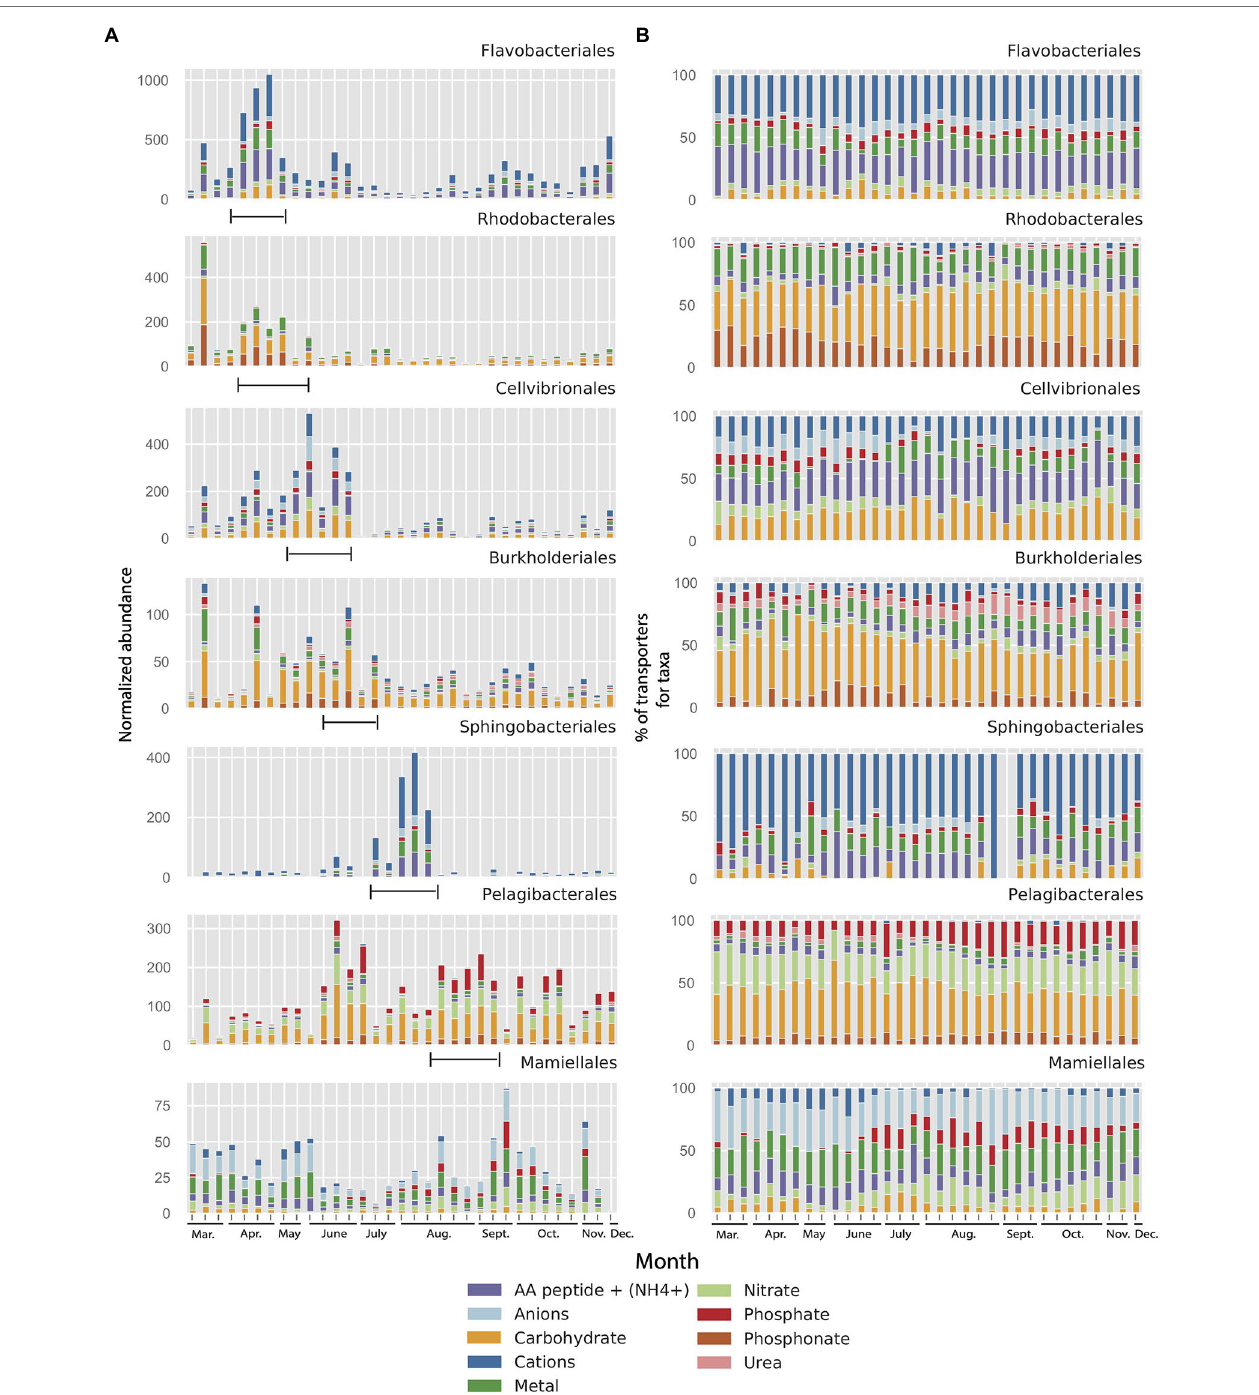
FIGURE 6 | (A) Normalized abundance of transporter clusters related to different substrate categories and their affiliation to seven microbial taxon (order) in the LMO 2012 metagenome dataset (10 months). Range mark in figure added manually to indicate the succession of transporter peaks. (B) Same data as in panel A but as percentages for each of the seven microbial taxa (order) in the LMO